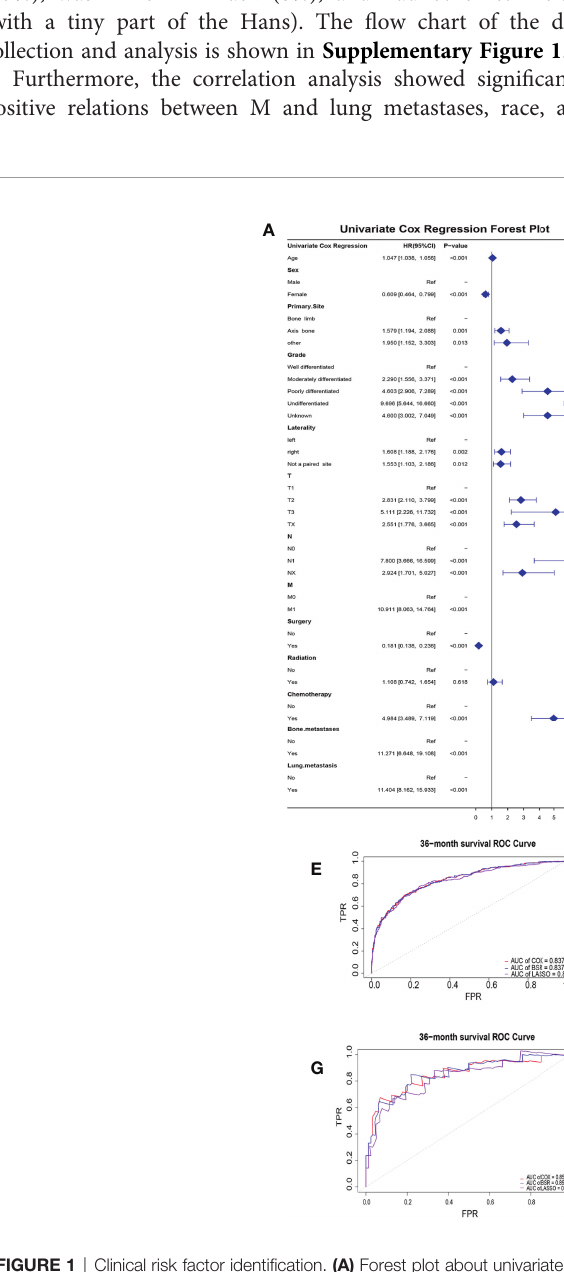
FIGURE 1 | Clinical risk factor identi fi cation. (A) Forest plot about univariate cox regression. (B) Best subset regression. A graph was drawn with the adjustment R ² as the criterion to see the combination of variables. (C) LASSO coef fi cient pro fi les of the 14 variables. When the b coef fi cient became zero, the variable made a negligible contribution to the model at this point and can be eliminated. (D) Partial-likelihood deviance curve for cross-validation of tuning parameter selection in the LASSO model. Two penalty values (tuning factors) l were given: one is the value of l when the mean squared error is smallest, i . e ., l .min; the other was the value of l within a range of variance of l .min. Receiver operating characteristic curves for the training (E, F) and validation (G, H) groups at 3- and 5-year overall